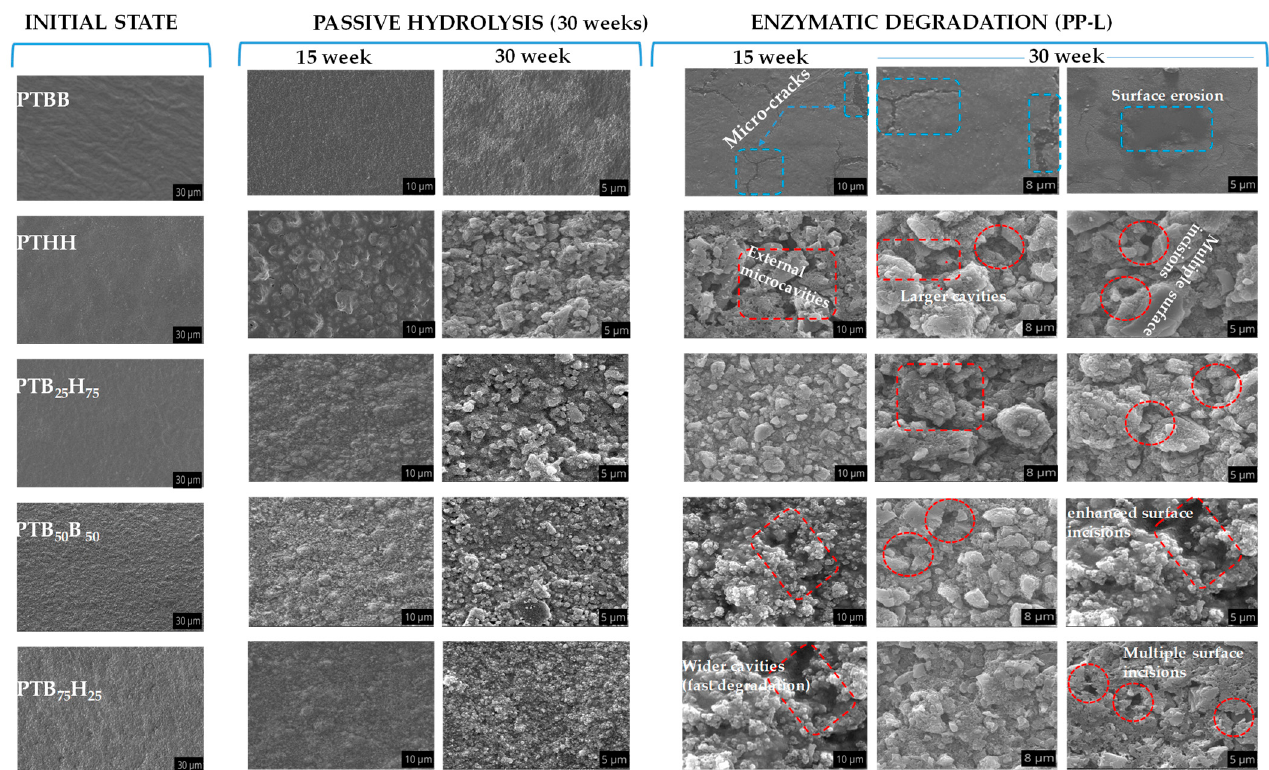
Figure 9. SEM micrographs of thepoly(1,4-bis(2-hydroxyethyl)benzene thiophenedicarboxylate) (PTBB), poly(hexylene thiophenedicarboxylate) (PTHH), and poly(hexylene 2,5-thiophenedicarboxylate-co-bis(2-hydroxyethoxybenzene) copolyester freeze-dried samples.